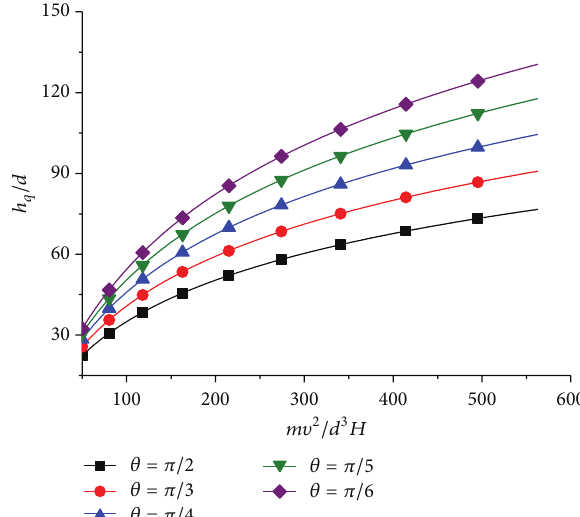
Figure 16: The scaling penetration